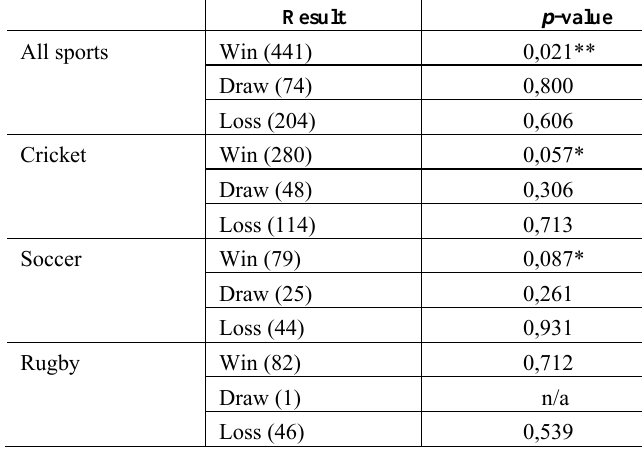
Table 5: Results of the Kruskal-Wallis H -test